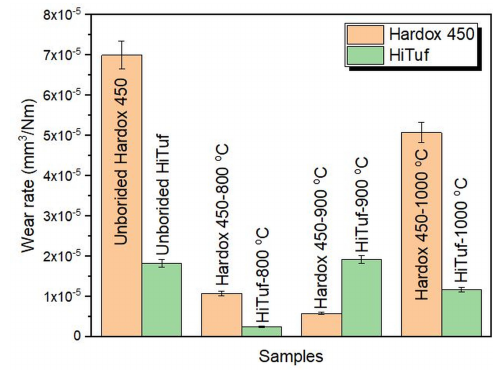
Figure 7: The change in wear rate of samples depending on boriding